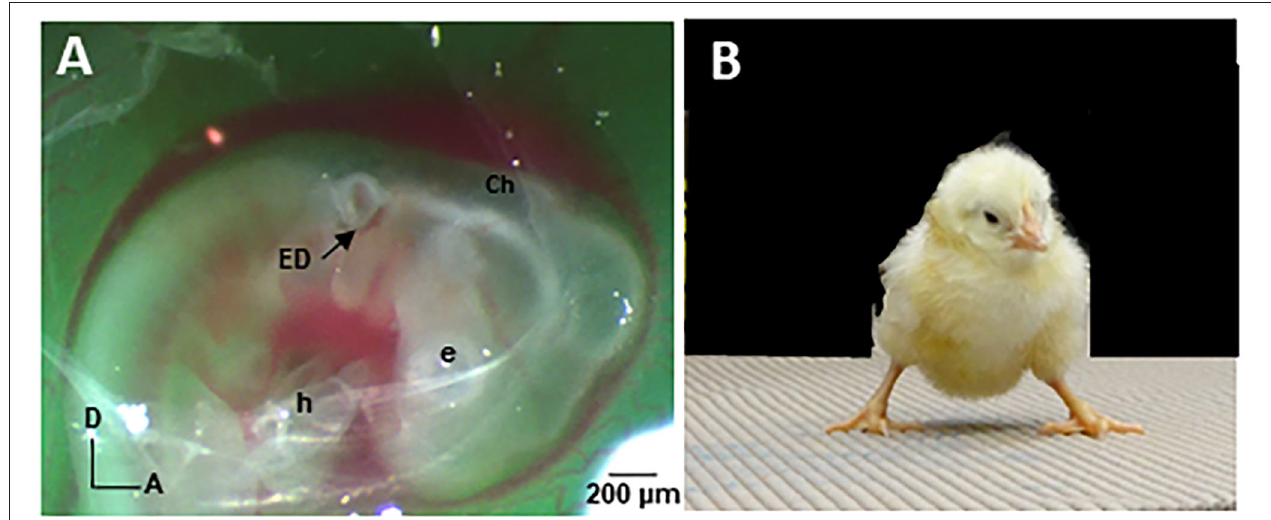
FIGURE 1 | (A) E2 chick in ovo viewed through a shell window under a stereo dissecting microscope (Zeiss Discovery.V8) after otocyst rotation. Fast green dye was injected to improve otocyst visibility. After tearing open the chorion (Ch) and amnion with forceps, the otocyst was cut free from the surrounding epithelium with a tungsten needle (10 µ m tip diameter; curved tip) and glided posteriorly along the epithelial surface before rotating it 180 ◦ in the anterior-posterior and dorsal-ventral axes. The rotated otocyst was returned to the epithelial slot. Note that the endolymphatic duct (ED) normally situated on the dorsal surface of the otocyst is located on the ventral surface after rotation. The shell window was sealed with tape and the egg reincubated at high humidity (70%) without egg turning ( 75). E, eye; h, heart. (B) Five-day-old hatchling ARO/s chick. Note the widened base of the feet after performing the righting reflex, indicating stress placed on the balance system